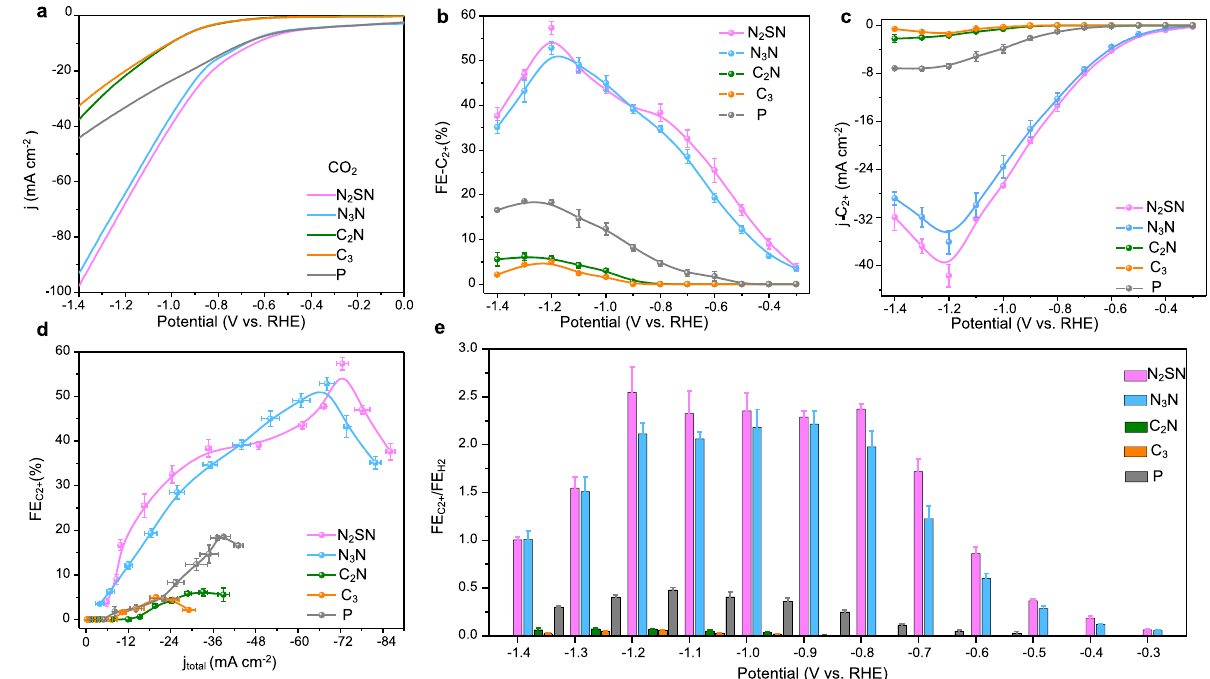
Fig. 2 CO 2 RR performance of the functionalized Ag – Cu electrodes in a H-cell. a Linear scan voltammetry (LSV) curves measured for different samples: N 2 SN, N 3 N, C 2 N, C 3 functionalized Ag – Cu compared to pristine (P) Ag – Cu in CO 2 -saturated 0.5 M KHCO 3 at electrochemical potential (V) from 0 to − 1.4 V vs. RHE. Scan rate, 20 mV s − 1 . b Faradaic ef fi ciency (FE) values for C − 0.3 to 2 + products on different samples at various potentials ranging from − 1.4 V vs. RHE and measured in 0.5 M KHCO j – V plots of the partial current densities for the C 3 . c 2 + products (ethylene and ethanol). d Relationships between the FE for C 2 + and the total current density for all the catalysts. ( e ), Selectivity for C 2 + products over hydrogen based on the ratio in FEs of C 2 + and hydrogen. The error bars in b – e correspond to the standard deviation of three independent